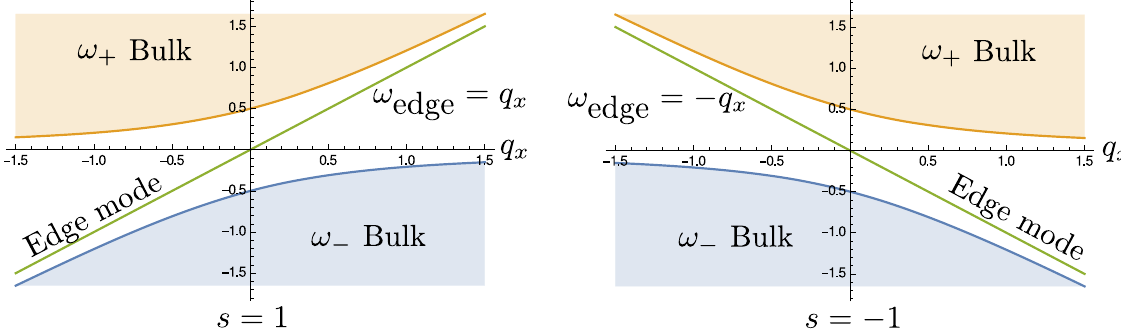
FIG. 4. The bulk and edge mode spectrum for the case when s ¼ (cid:3) 1 (shown for the simple case when μ ¼ ¯ v 1 ) and m ð y Þ varying from − 1 to þ 1